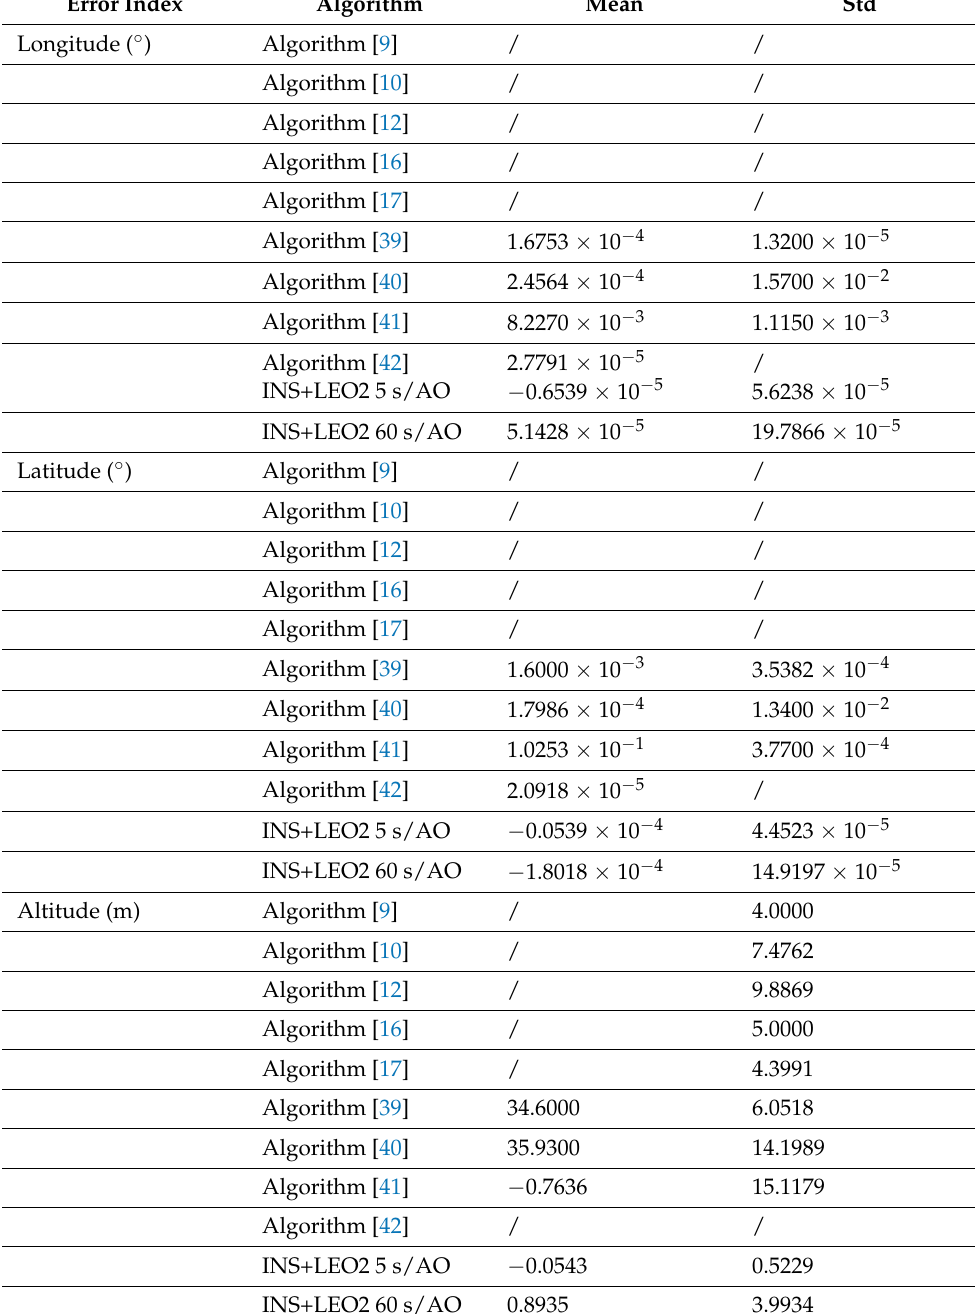
Table 6. INS+LEO2-satellite adjacent orbit alternate switching ranging integrated navigation posi- tioning algorithm and other algorithm error calculation